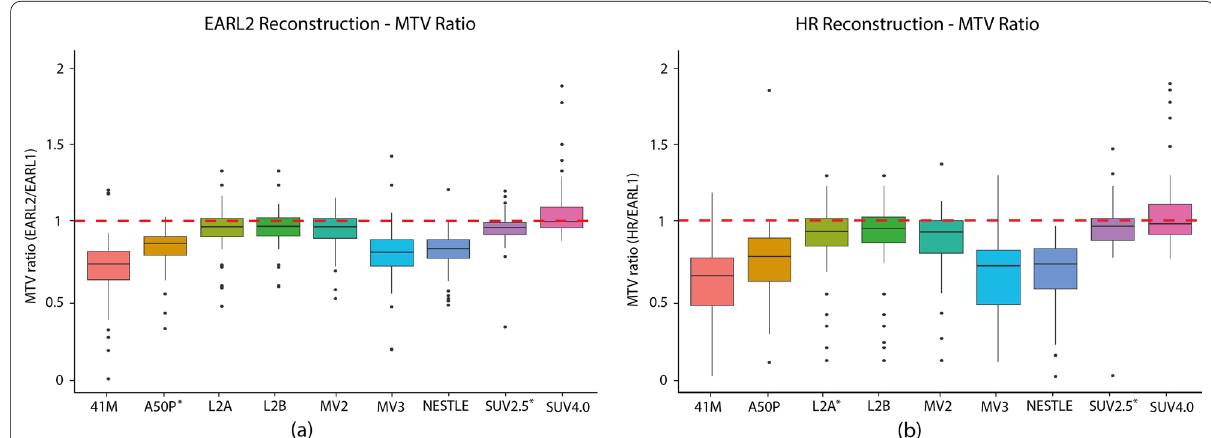
Fig. 1 MTV ratios across segmentation methods. Each boxplot illustrates the set of MTV ratios obtained with a particular segmentation method: 41M, A50P, L2A, L2B, MV2, MV3, NESTLE, SUV2.5 or SUV4.0. MTV ratios are given for a EARL2 reconstructions and b HR reconstructions. * Implies few outliers not